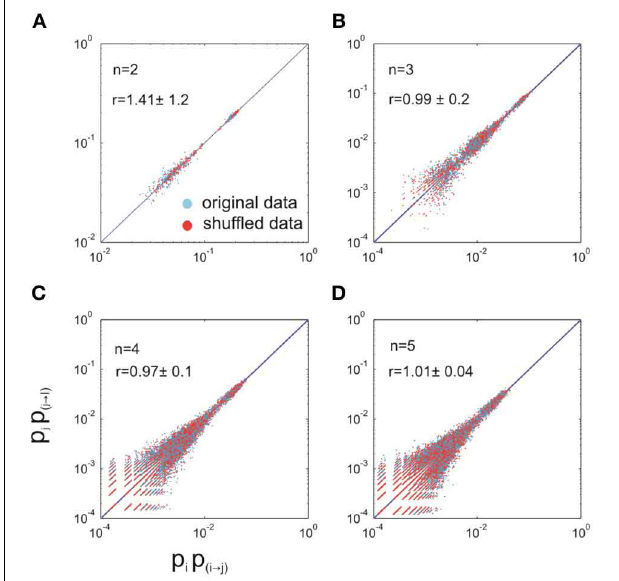
FIGURE A1 | Detailed balance approximately holds for the data with quiescent periods removed. For differently sized systems ( n = 2–5), empirically measured p i p i → j is plotted against p j p j → i for both the original data ( blue ) and shuffled data ( red ). For every size, 100 different systems (i.e., different combinations of electrodes) were analyzed. The solid lines represent equality. r is a measure of the distance from the equality, relative to that of the shuffled data (see Appendix text A for details). It is represented as mean ± s.d. (across 100 systems). (A–D) , system size equals 2, 3, 4, and 5,